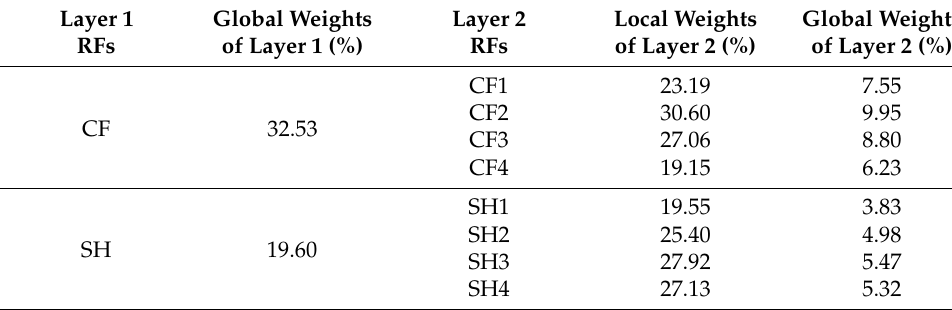
Table 6. The consequence weights of risk factors